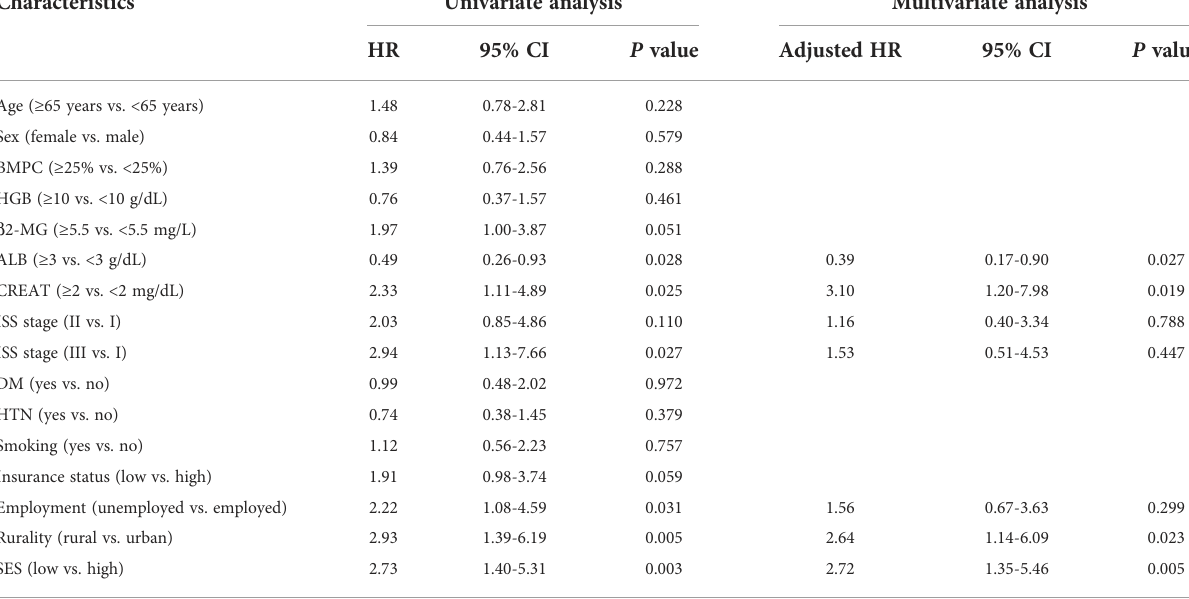
TABLE 5 Univariate and multivariate Cox regression analysis for OS in the training cohort.